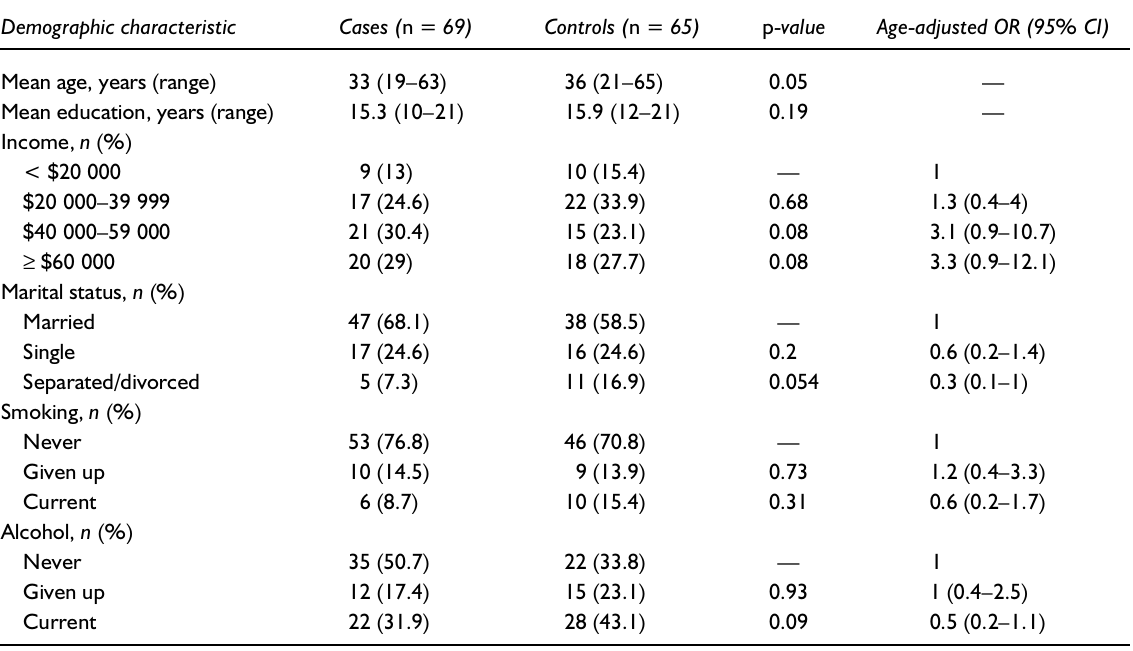
Table 1 Demographics, sexual behavior and physician-diagnosed genital diseases of VVS cases and Demographic characteristic